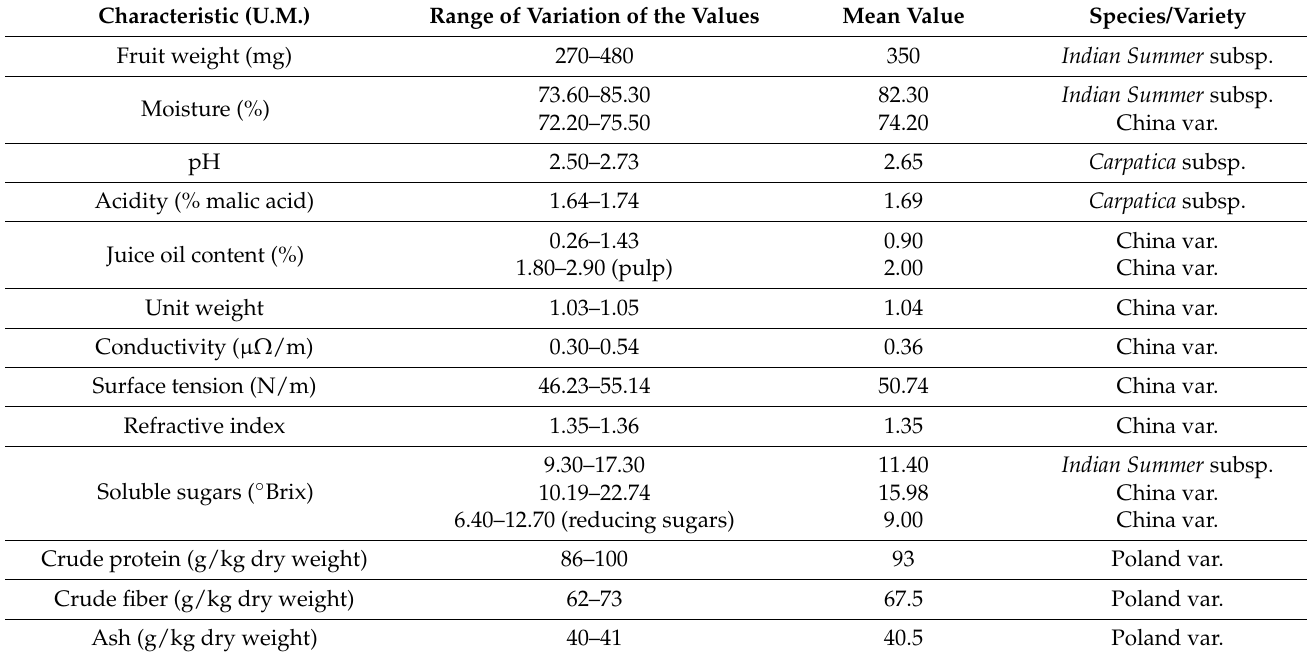
Table 1. Physico-chemical properties of sea buckthorn juice/berries